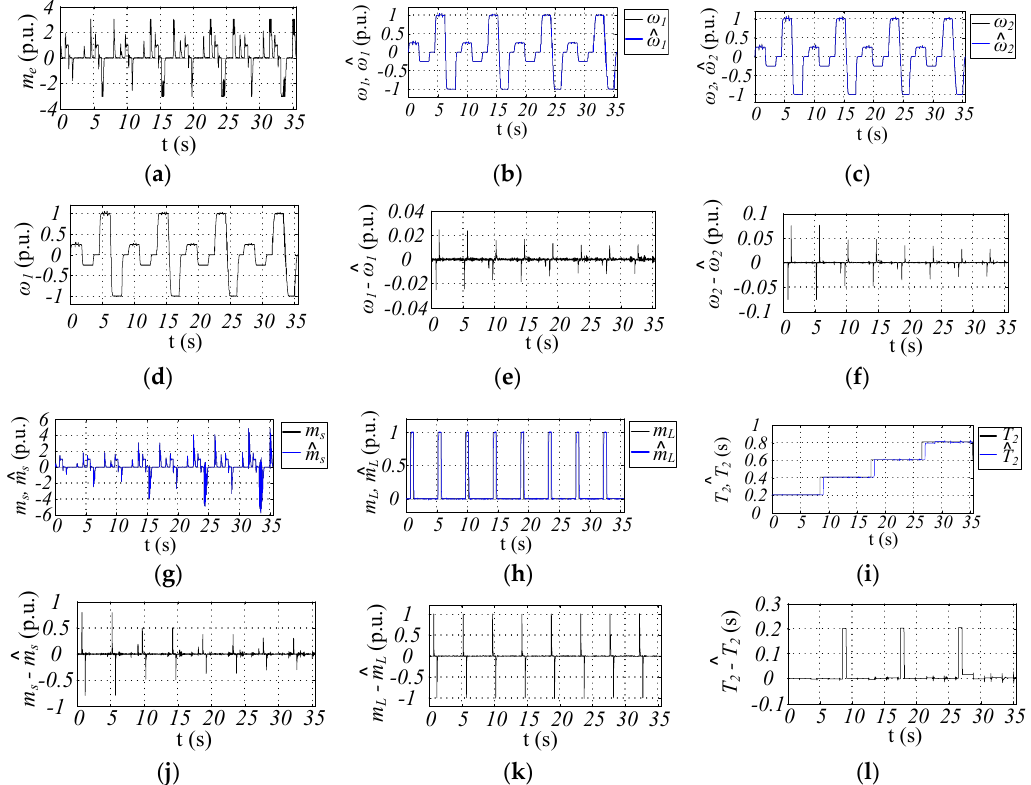
Figure 4. Transients process of the adaptive control structure with the FUKF estimator—the simulation